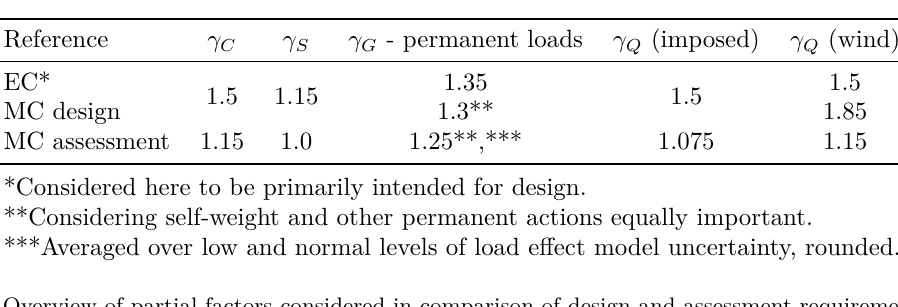
Table 4. Overview of partial factors considered in comparison of design and assessment requirements (CC2).